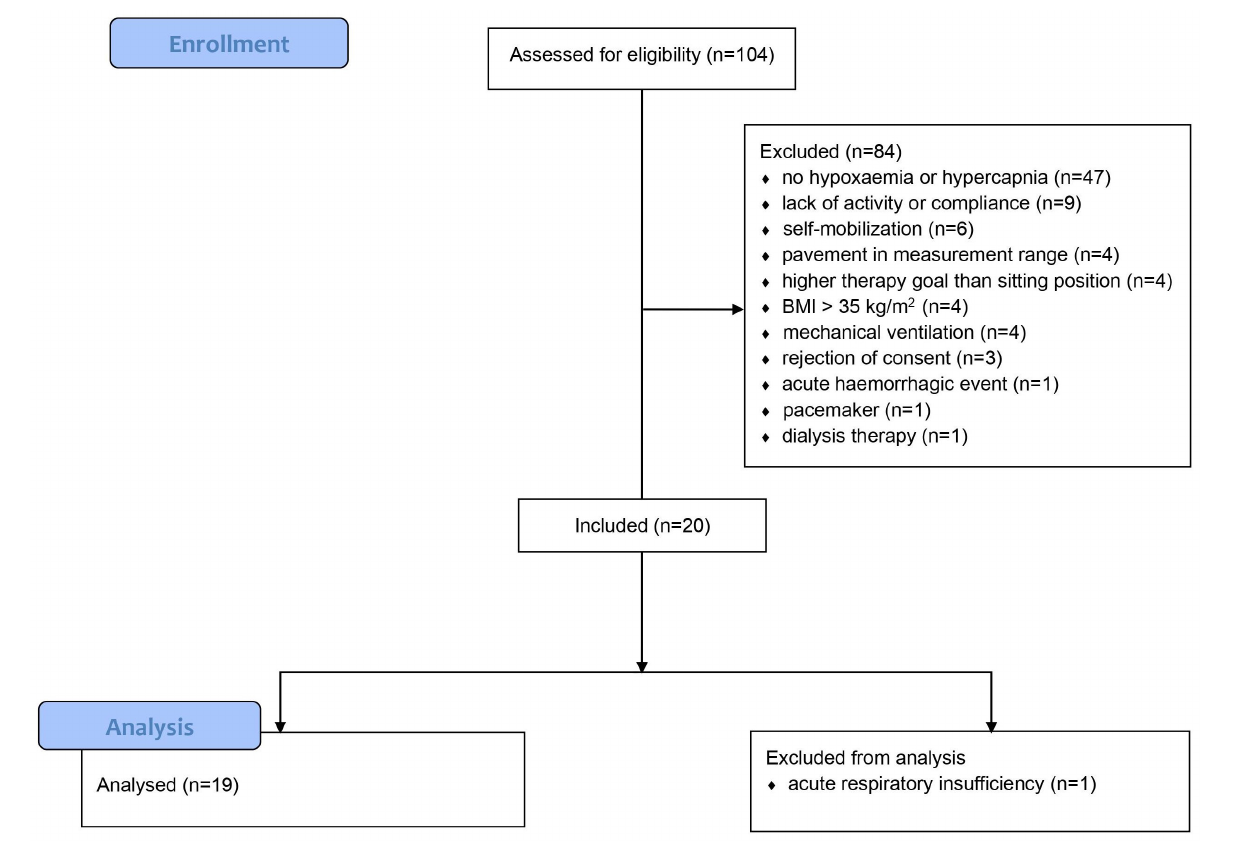
FIGURE 1 | Study flow